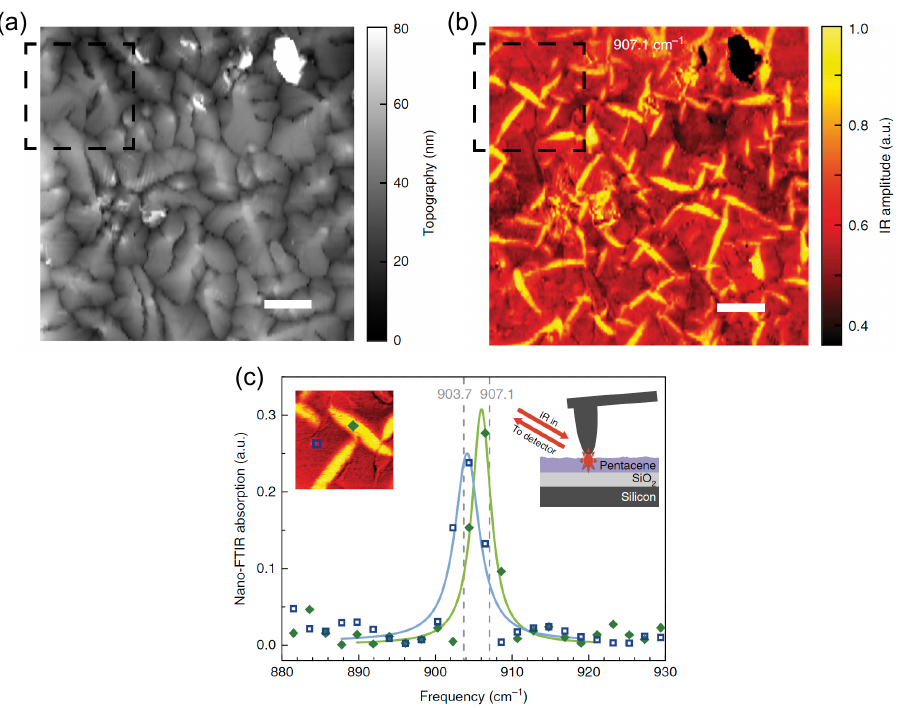
Figure 4. S-SNOM IR and FTIR images. ( a ) AFM topography of a pentacene thin film; ( b ) the corresponding IR-SNOM image excited with 907 cm − 1 wavelength light, scale bar is 2 μ m; ( c ) Nano-FTIR spectra taken at two different locations representing the thin film and bulk phases of a pentacene film (40-nm thick) deposited on an SiO 2 substrate. Lorentzian fits (curves) to the data reveal that the bulk phase (green line, yellow ellipsoids in the image) displays a higher resonance frequency than the surrounding thin film phase (blue line, red phase in the images). Reproduced with permission from [45], Copyright Nature communications, 2014.